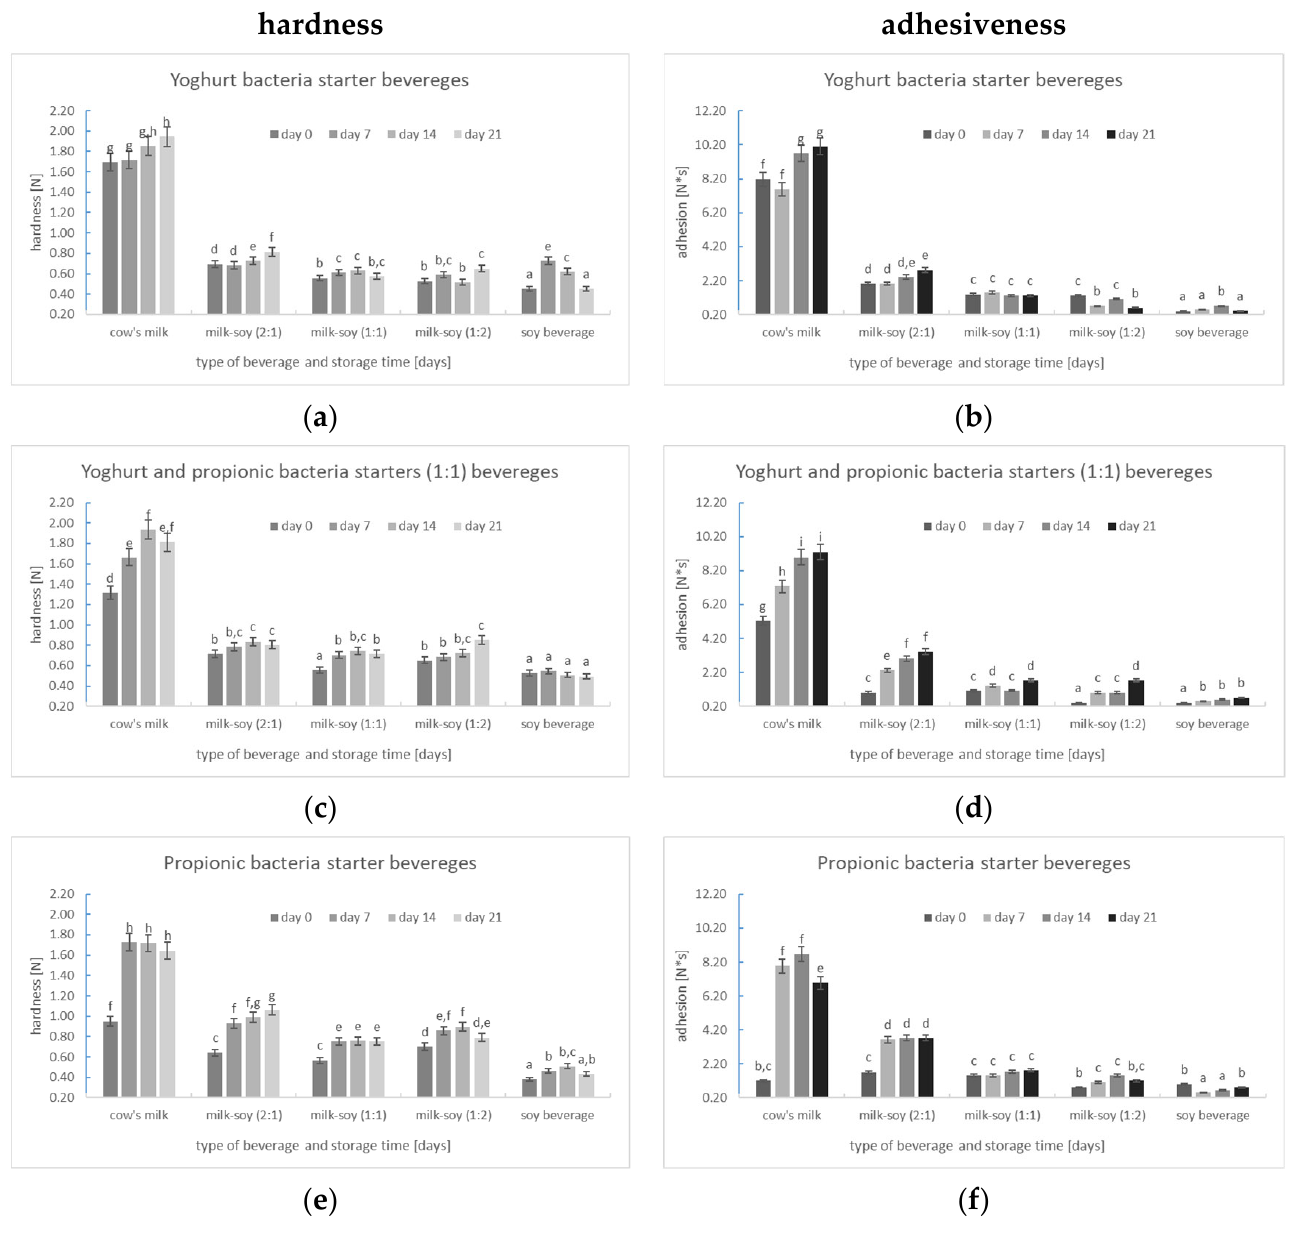
Figure 2. ( a–f ) Changes in the hardness ( a , c , e ) and adhesiveness ( b , d , f ) of milk, milk–soya, and soya yoghurt products obtained from beverages fermented using different starter cultures and stored at 5 °C for 21 days (mean values and standard deviations). a,b,c,d,e,f,g,h,i —The same letters on each chart mean there are no statistically significant differences between the compared numerical values ( p <